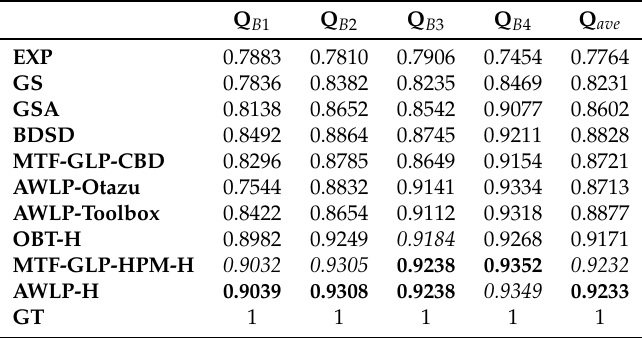
Table 4. Degraded-resolution QuickBird Trento dataset: Q-indexes for each spectral band, where B 1, B 2, B 3, and B 4 are the blue, the green, the red, and the NIR bands, respectively. The Q ave column represents the averaged values. Best results in boldface; second best in italic.